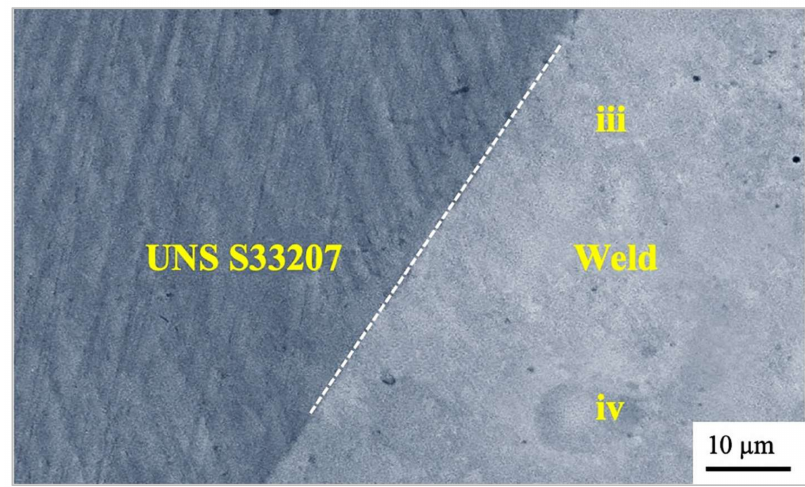
Figure 5. SEM image of the weld zone (from area B in Figure 2). iii and iv are the areas where EDS performed.